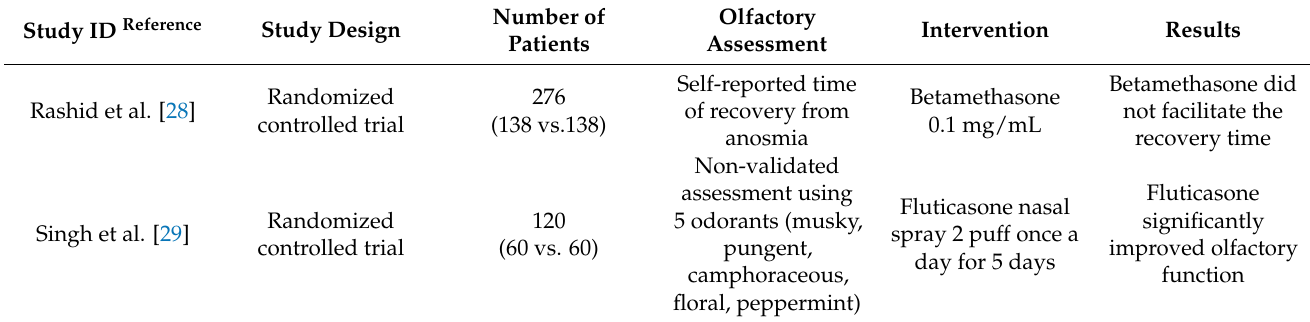
Table 1. Assessment of olfactory improvement according to intranasal steroid application